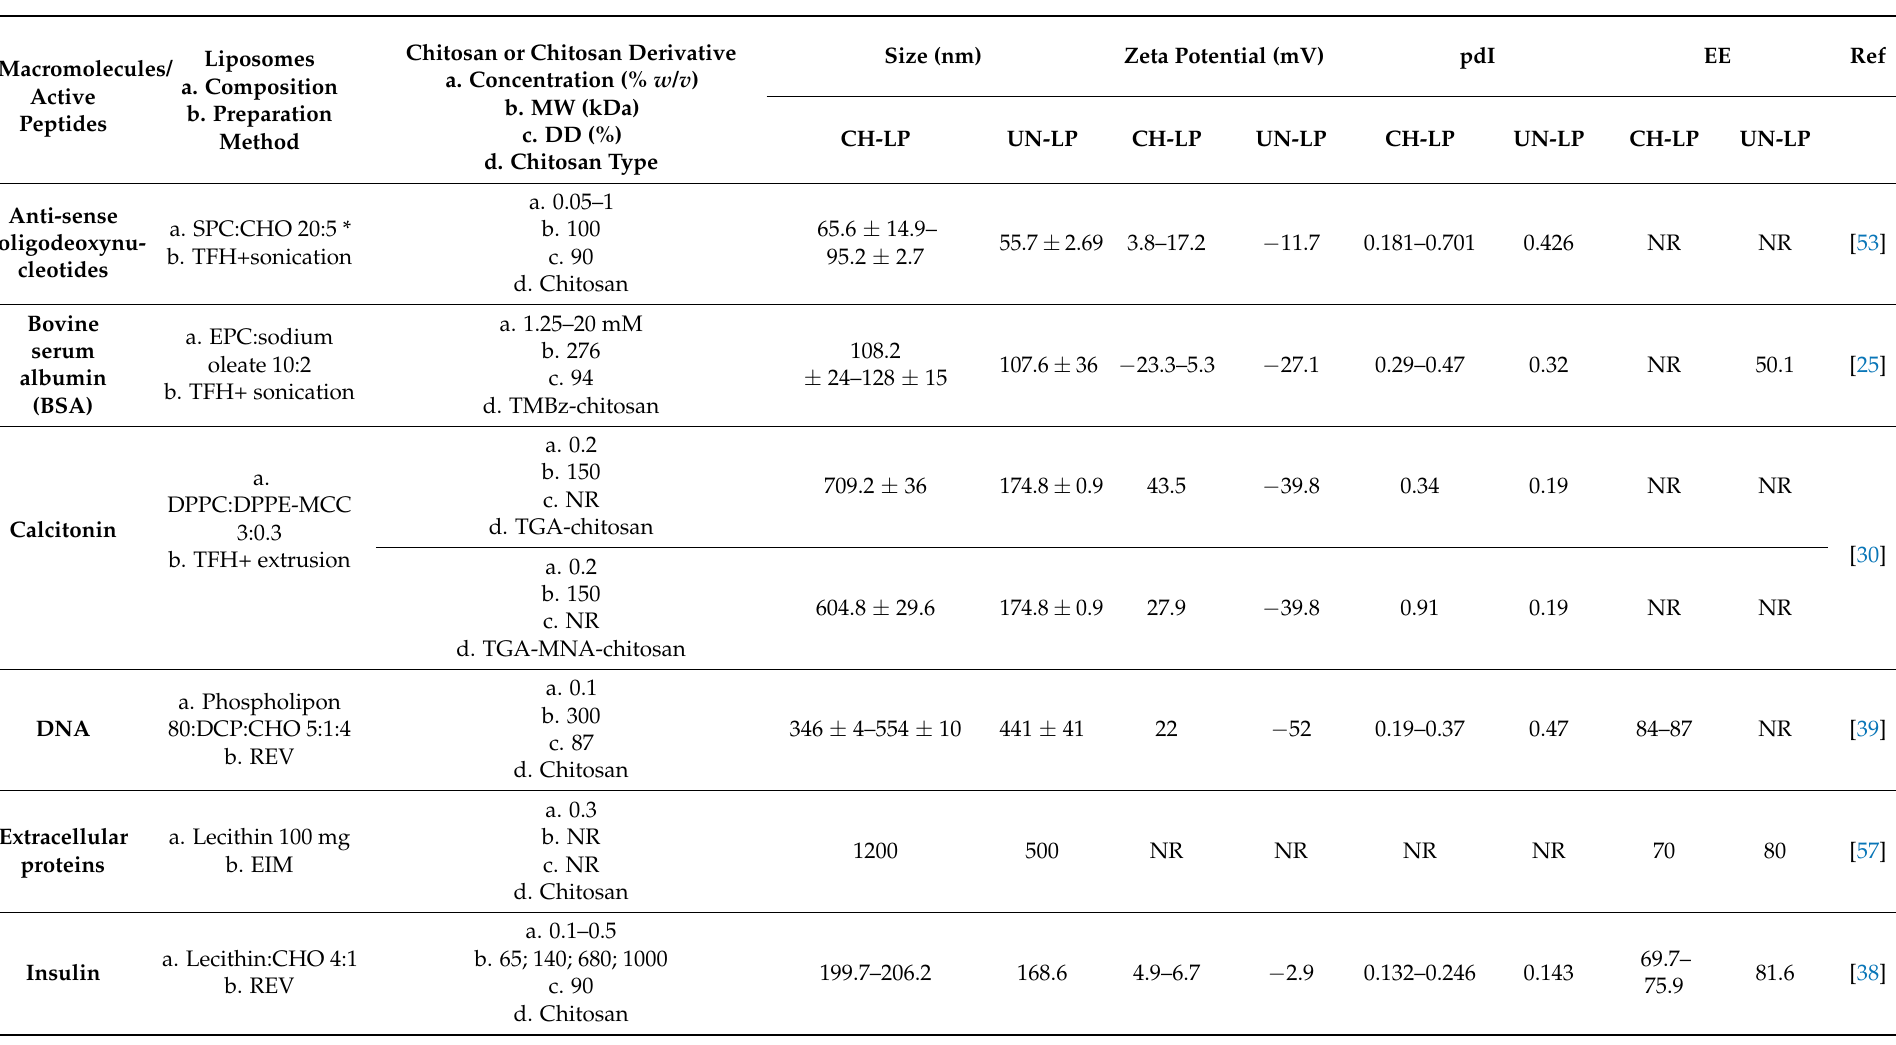
Table 5. Comparison of size, surface charge, homogeneity and drug EE between liposomes and chitosomes loading macromolecules and active peptides. The liposomal composition is indicated in the table in molar ratio except when * exists, indicating a weight ratio ( w/w